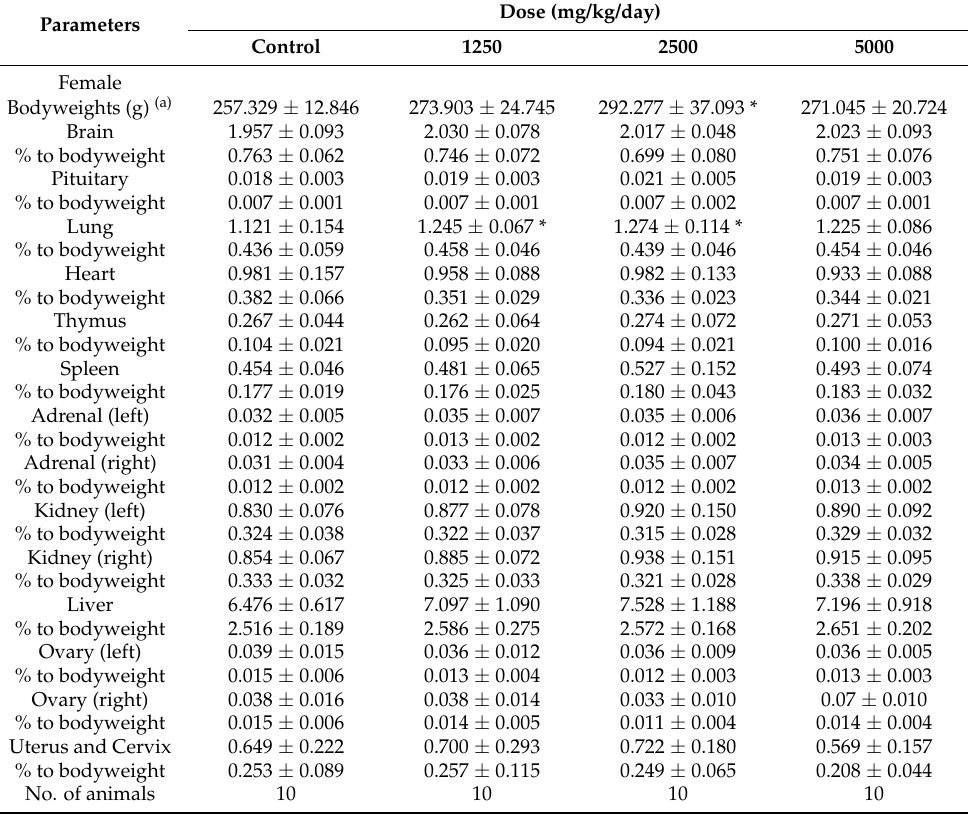
Table 12. Absolute and relative organ weights in 13 weeks repeated oral dose toxicity of WG extract in female rats.